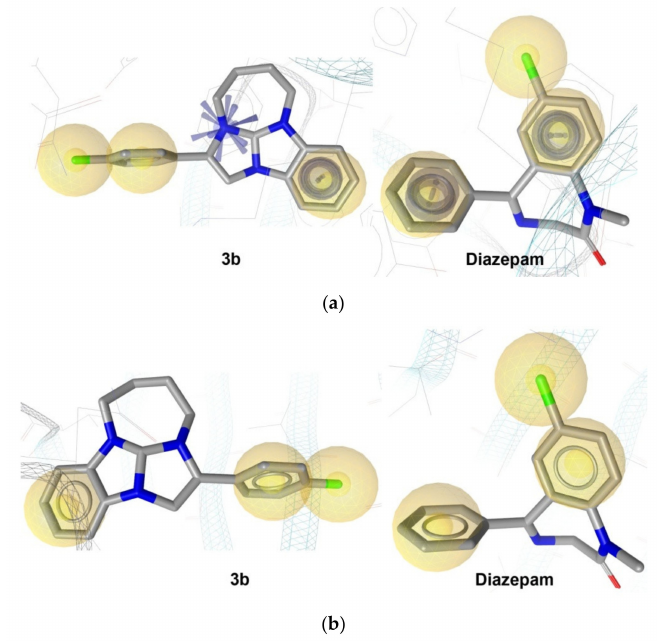
Figure 6. Location of the compounds in the GABA A receptor sites; ( a ) benzodiazepine site; ( b ) GABA-binding site.